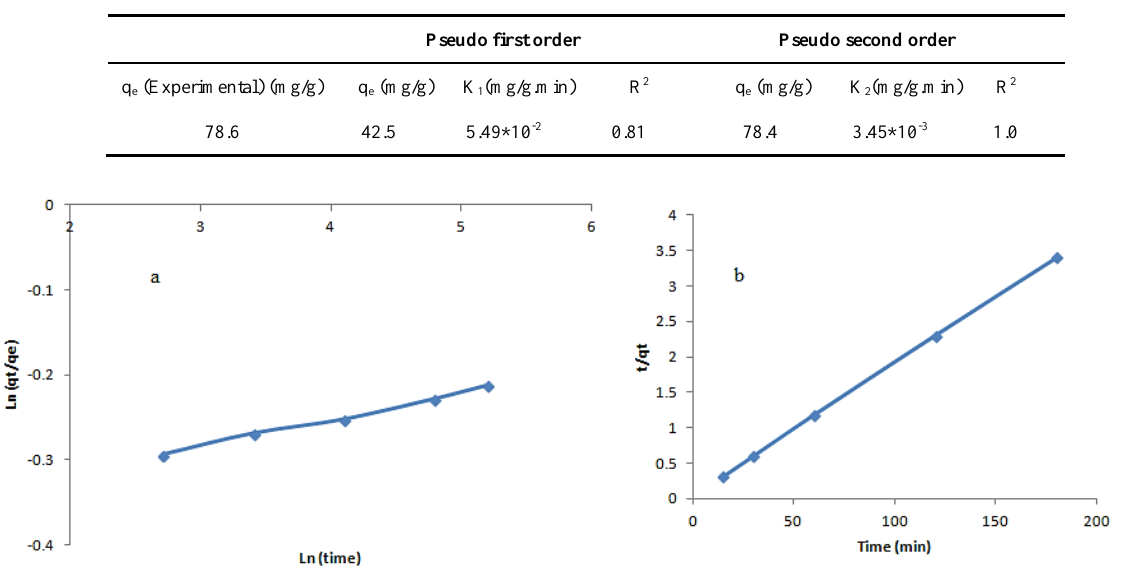
Table 1. The kinetic data of the carmine dye adsorption.